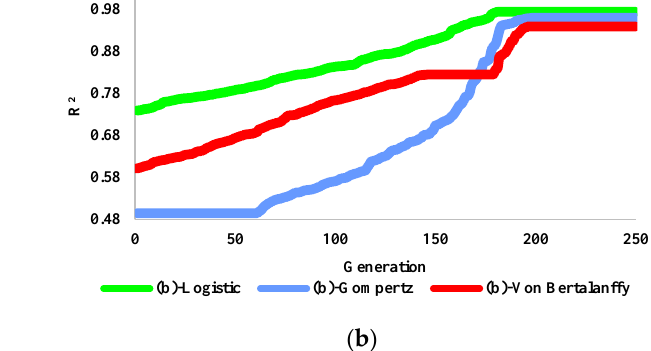
Table 5. Comparison of the obtained results for the three tested models for pigs.